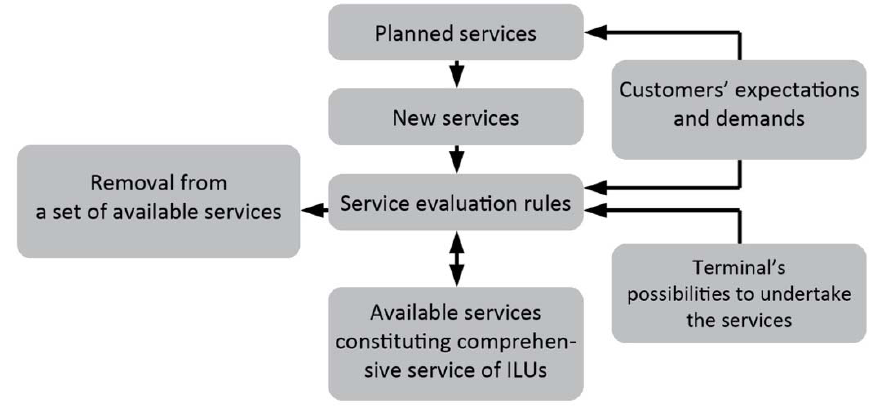
Figure 3. The method of decision making during assessment related to compatibility of available and newly introduced services.